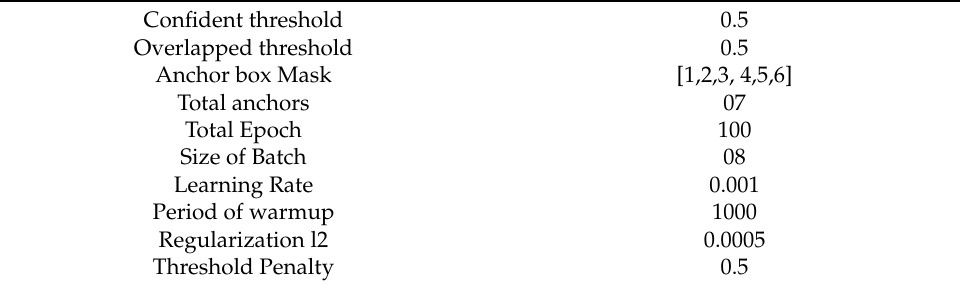
Table 3 states the training parameters. Table 3. Parameters of YOLOv3-RES-net-50